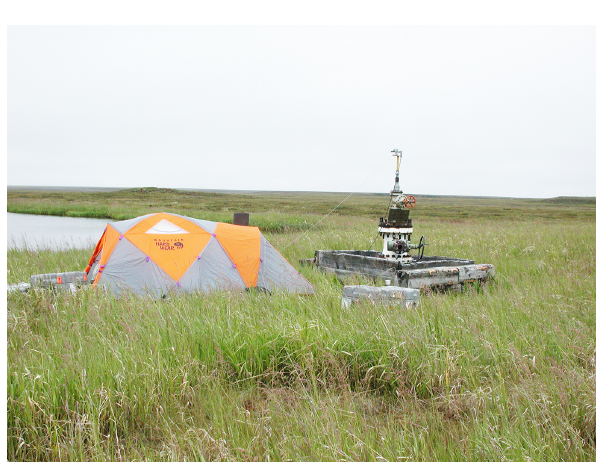
Table 1. USGS and GTN-P well codes, location, maximum accessible depth, and date of first temperature log for the DOI/GTN-P monitoring wells. Boreholes coupled with a nearby DOI/GTN-P climate station are indicated. Borehole USGS GTN-P Latitude Atigaru Test Well No. 1 Awuna Test Well No. 1 Drew Point Test Well No. 1 East Simpson Test Well No. 1 East Teshekpuk Test Well No. 1 Echooka Unit No. 1 Ikpikpuk Test Well No. 1 J. W. Dalton Test Well No. 1 Koluktak Test Well No. 1 Kugrua Test Well No. 1 Kuyanak Test Well No. 1 Lisburne Test Well No. 1 Lupine Unit No. 1 North Inigok Test Well No. 1 North Kalikpik Test Well No. 1 Peard Bay Test Well No. 1 Seabee Test Well No. 1 • South Harrison Test Well No. 1 South Meade Test Well No. 1 Tulageak Test Well No. 1 Tunalik Test Well No. 1 West Dease Test Well No. 1